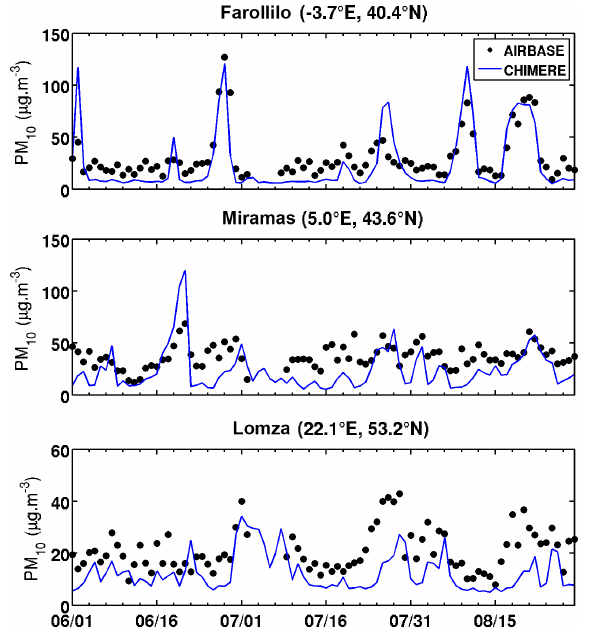
Figure 3. Time series from 1 June to 31 August of daily mean sur- face PM 10 concentrations from three stations of the AirBase net- work. The top station is located near Salamanca in Spain, mid- dle is in Miramas in the south of France, and bottom is in Lomza in Poland. The corresponding simulated CHIMERE concentrations (spatially co-localized) are also indicated (blue